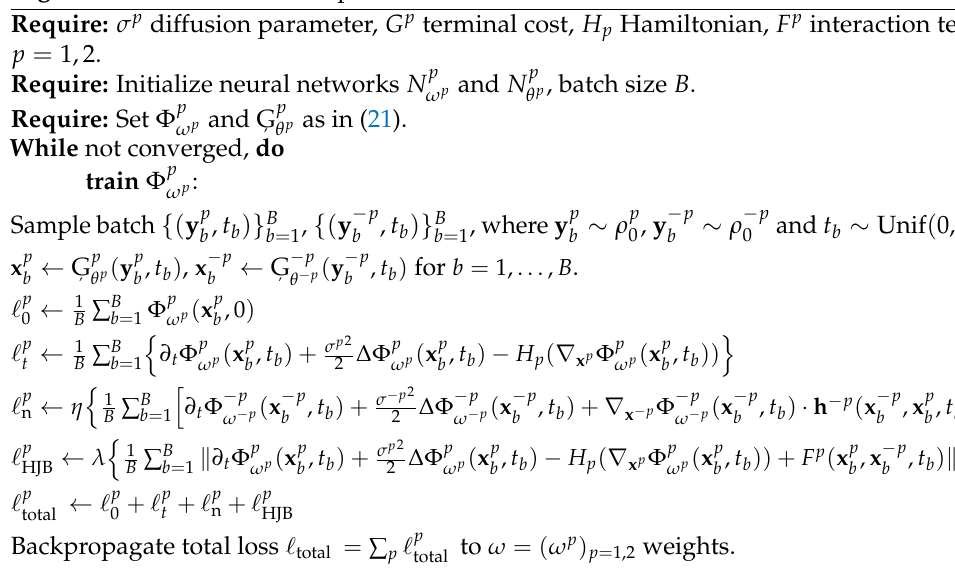
Algorithm 1 ECA-Net for cooperative attack–defense